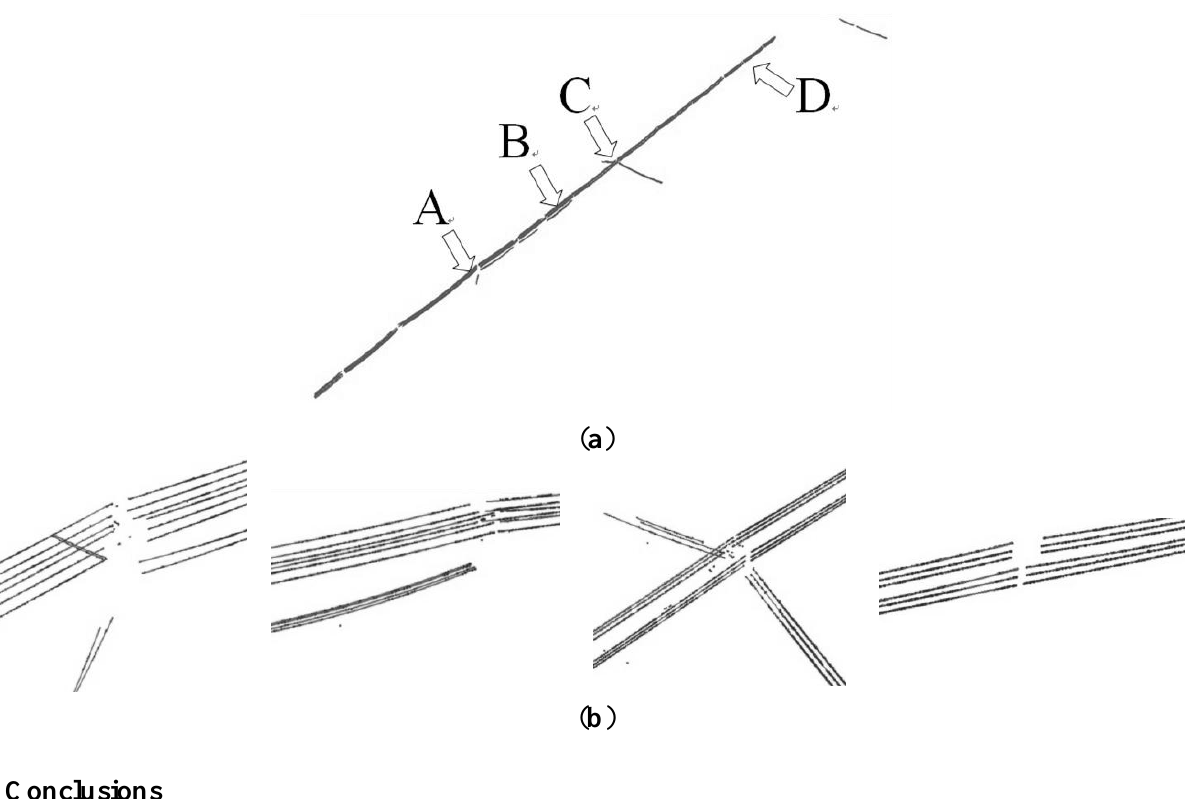
Figure 11. Three-dimensional (3-D) power line fitting. ( a ) The fitted 3-D power lines. ( b ) Magnified sections of the fitted result at points A, B, C and